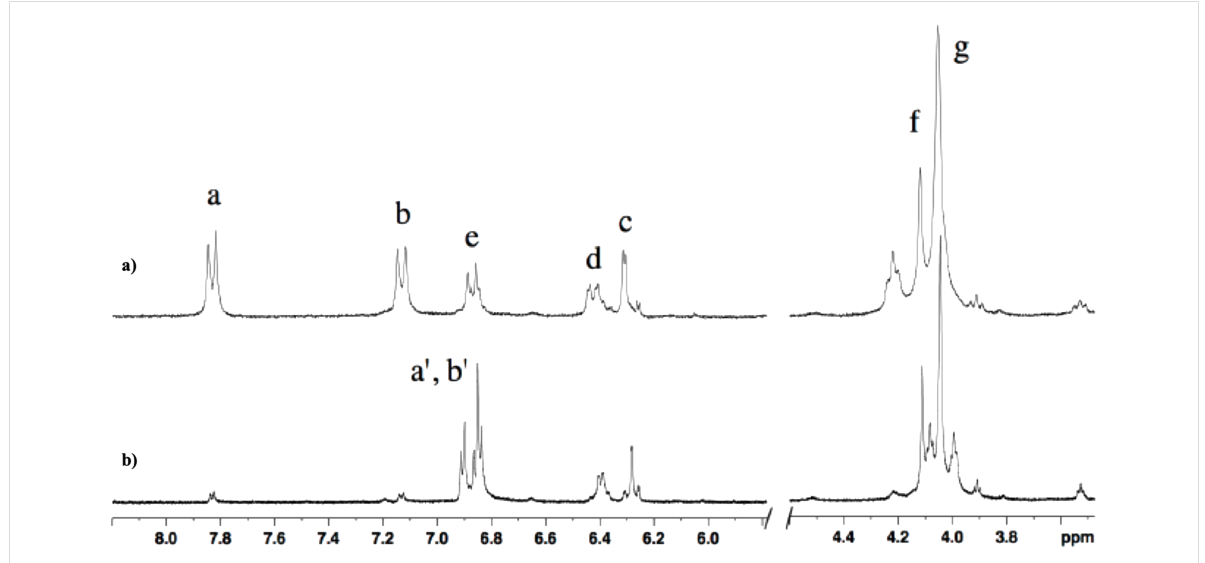
Figure 4: 1 H NMR spectra (300 MHz) recorded at room temperature (298 K) in D 2 O of a) the thermodynamically stable trans- 1 E and b) at the photo- stationary state (PSS) after irradiation at 365 nm (88% of 1 Z and 12% of 1 E at PSS).